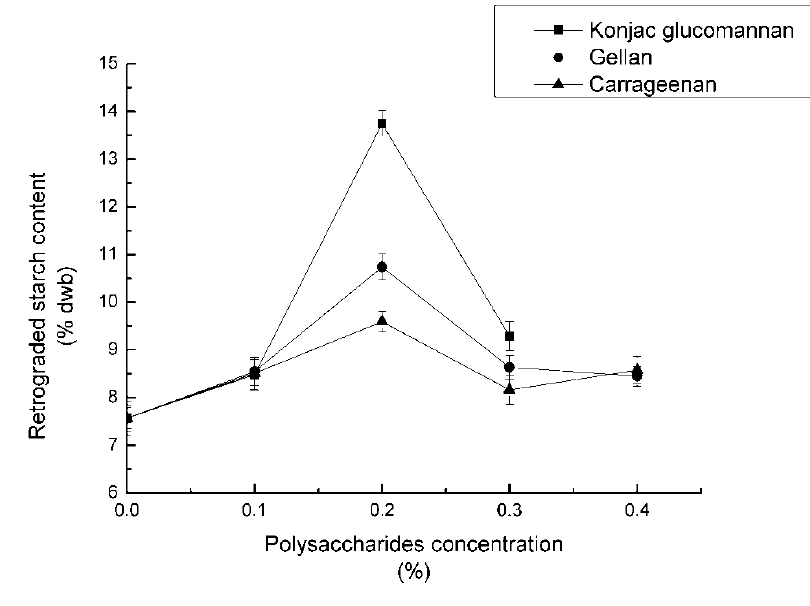
Figure 1. Effect of concentration of polysaccharides on RS